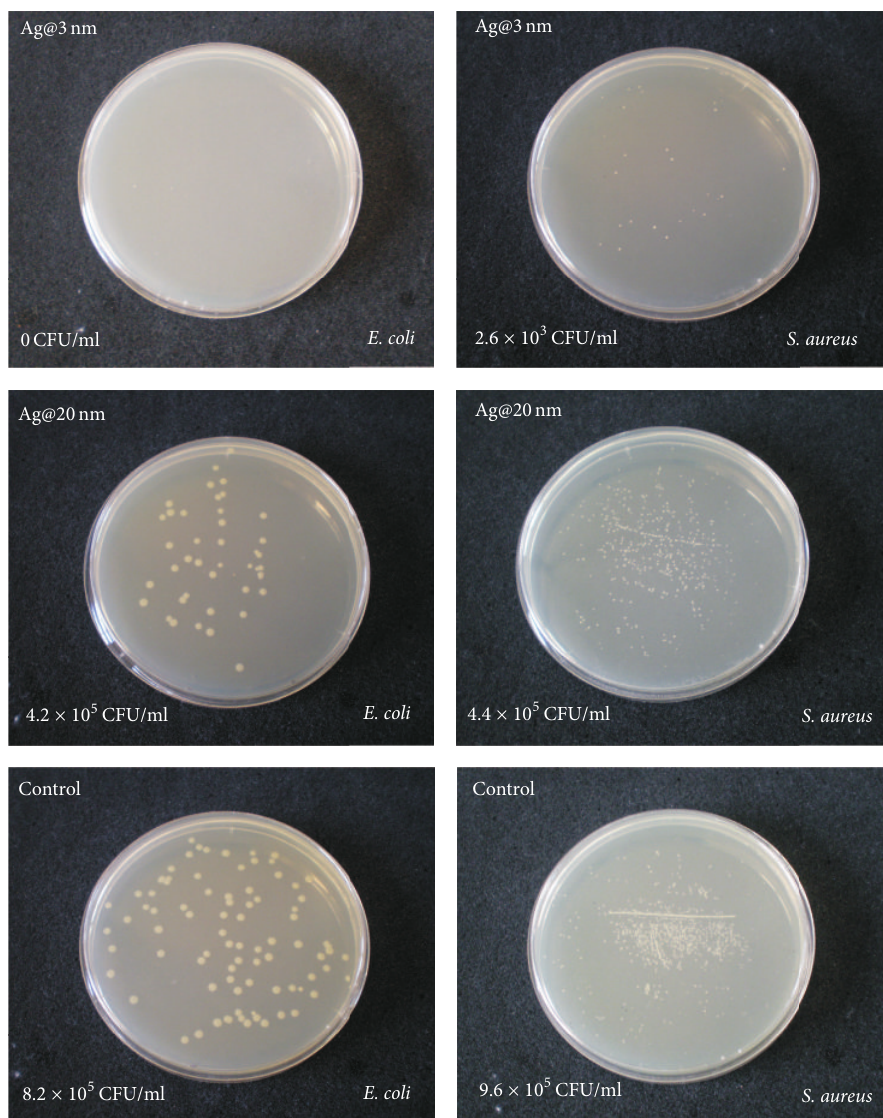
Figure 5: Antibacterial activity of Ag NPs with different sizes against E. coli (ATCC 25922) and vancomycin-intermediate resistant S. aureus ATCC